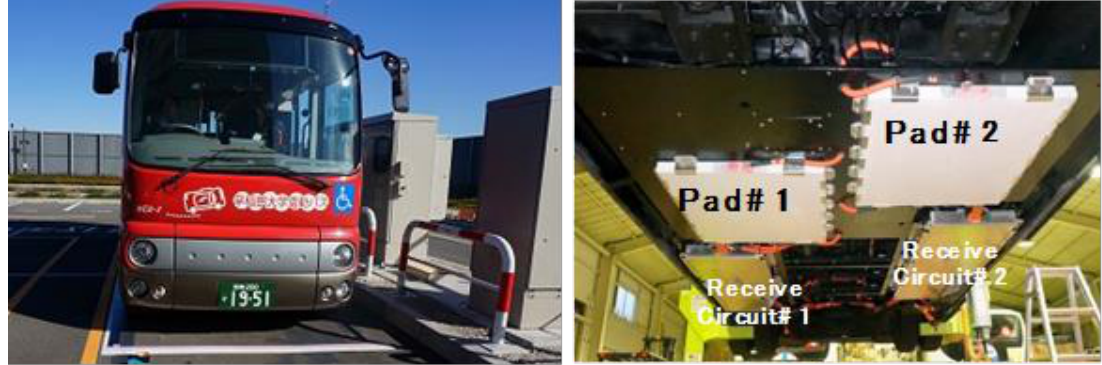
Figure 6. The Small Bus (WEB3 Advanced) and the Receive Equipment installed to the Bus.